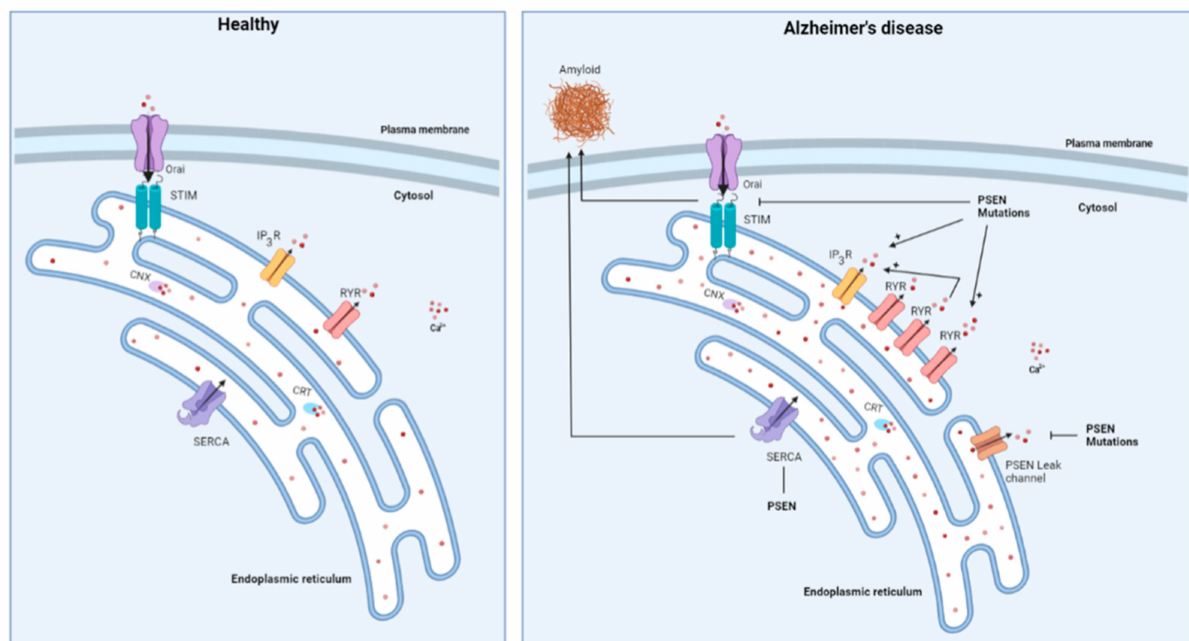
Figure 2. Schematic overview of changes in ER Ca 2+ handling occurring in Alzheimer’s disease. Mutations in presenilin (PSEN) were shown to increase the expression of the RyR and to cause an enhancement of IP 3 R-mediated Ca 2+ release. Additionally, the RyR is responsible for some of the IP 3 R-mediated Ca 2+ release through CICR. PSENs were also reported to form ER Ca 2+ leak channels, a function that is abolished by PSEN mutations and which causes ER Ca 2+ overload. PSEN mutations also display an inhibitory effect on store-operated Ca 2+ entry, which may be involved in the generation of toxic A β deposits. Finally, PSENs interact with SERCA which also impacts the A β